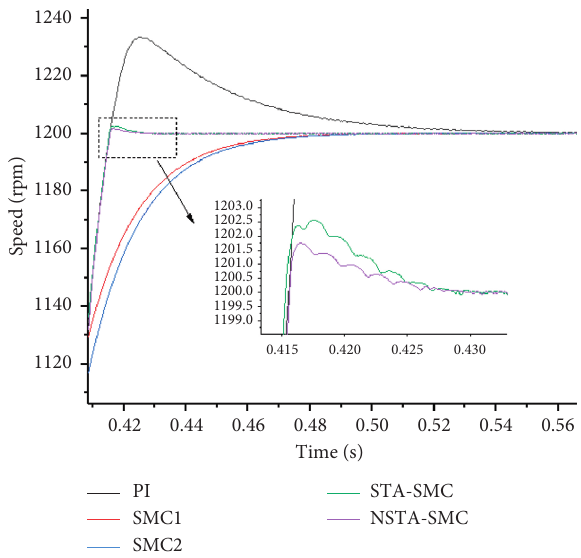
Figure 5: Enlargement of local speed (c).